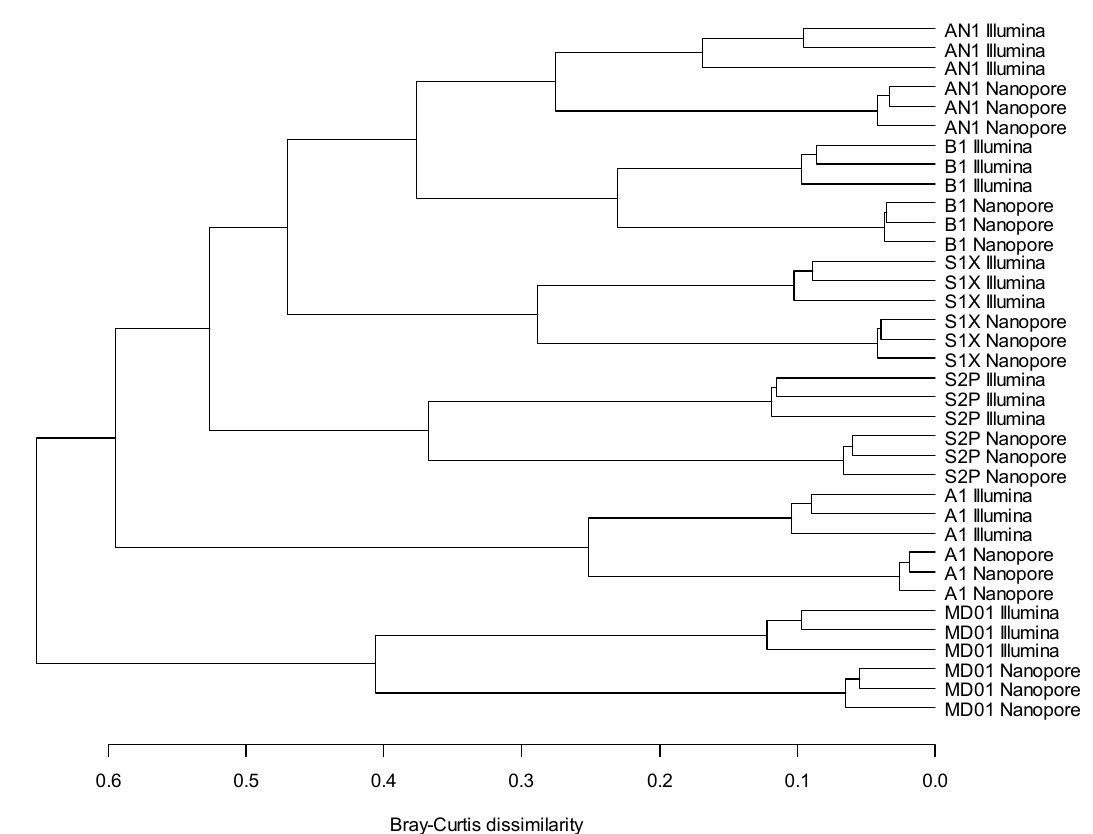
Figure 2. Clustering of the faecal samples based on their species-level bacterial community struc- ture.